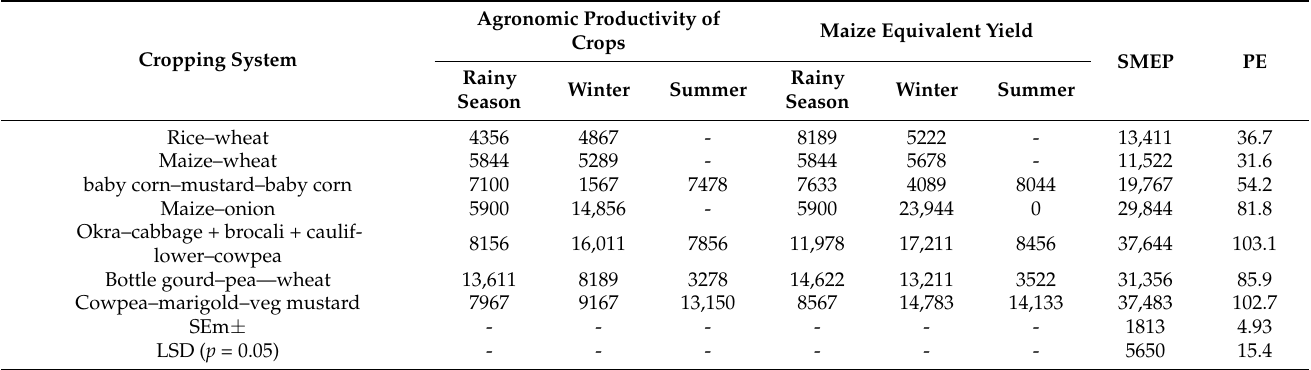
Table 4. Agronomic productivity (kg/ha), equivalent yields (kg/ha), and production efficiency (kg/ha/day) of different cropping systems under integrated farming systems.